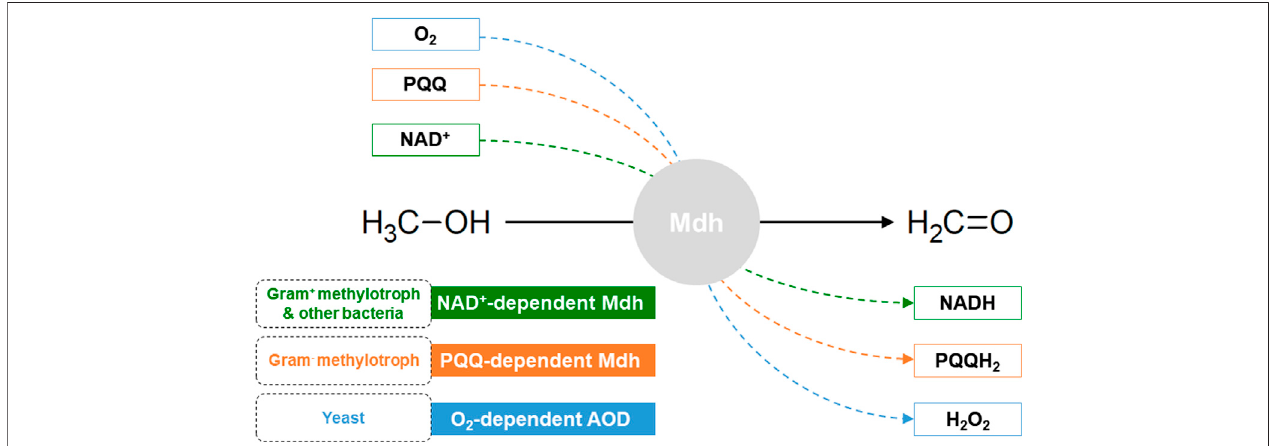
FIGURE 2 | Three classes of methanol dehydrogenases